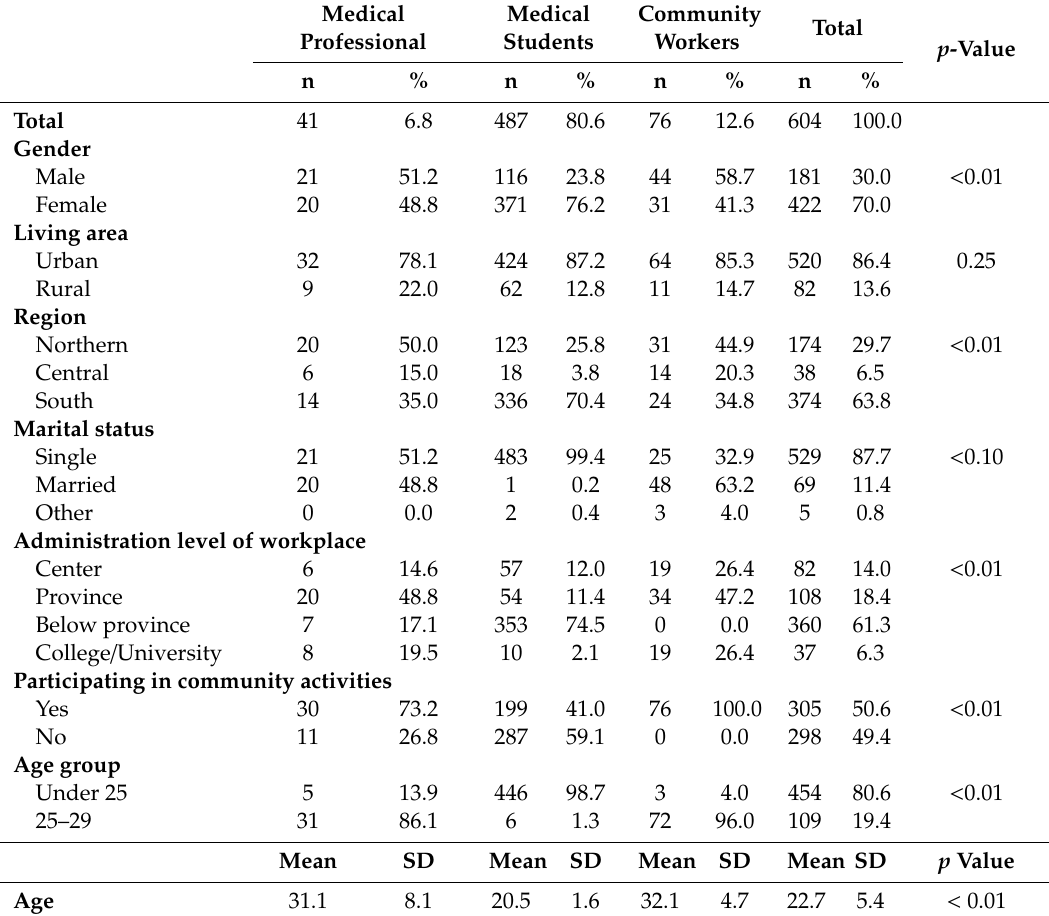
Table 1. Demographic characteristics of participants.